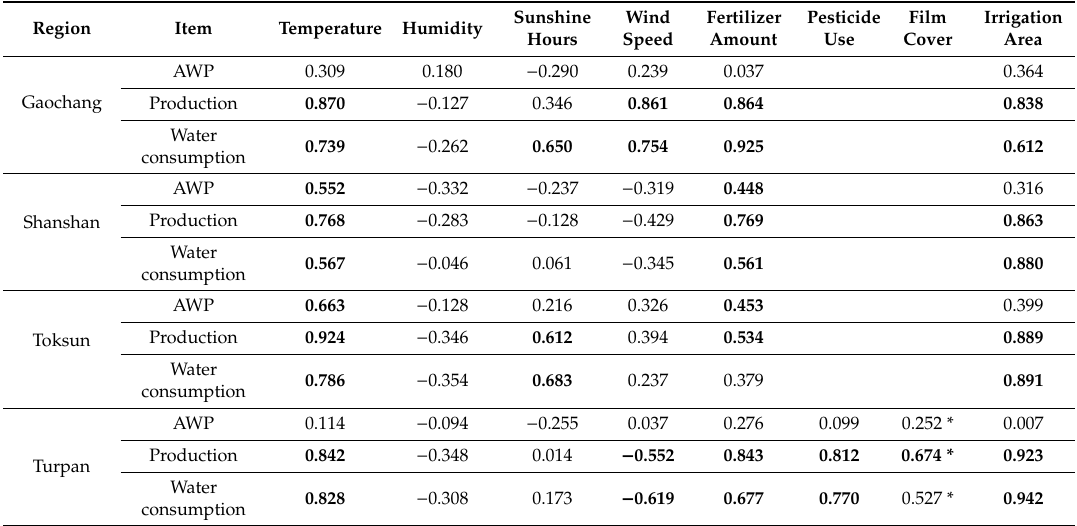
Table 2. Pearson correlation coe ffi cients involving AWP, production, water consumption and impact factors in Turpan and three